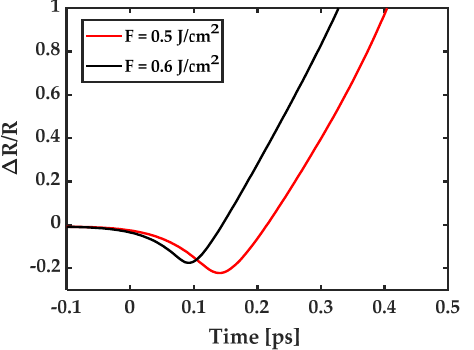
Figure 7. Relative reflectivity as a function of delay time. The time zero aligns with the experimental data.